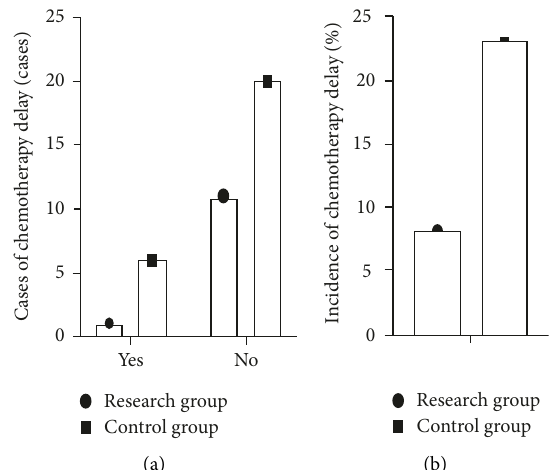
Figure 2: Comparison of the occurrence of chemotherapy delay for both groups. (a) Cases of chemotherapy delay (cases) and (b) incidence of chemotherapy delay